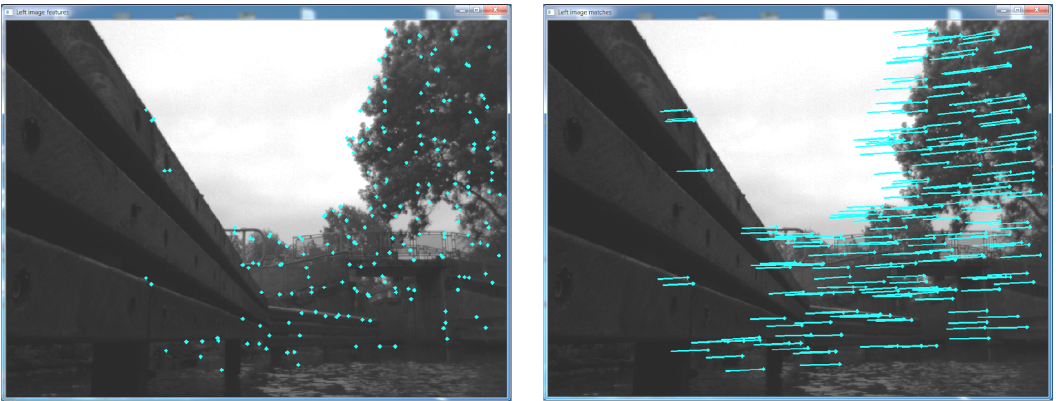
Figure 3. Detection ( Left ) and matching ( Right ) of sparse image features after feature reduction through